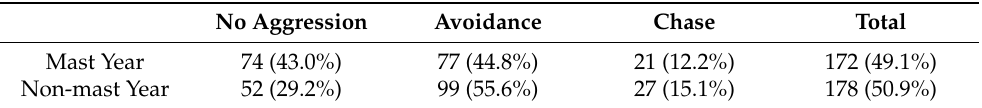
Table 2. Aggressive behaviour of Apodemus mice towards bank voles, Clethrionomys glareolus , distin- guished between the mast year and the non-mast year. No Aggression Avoidance